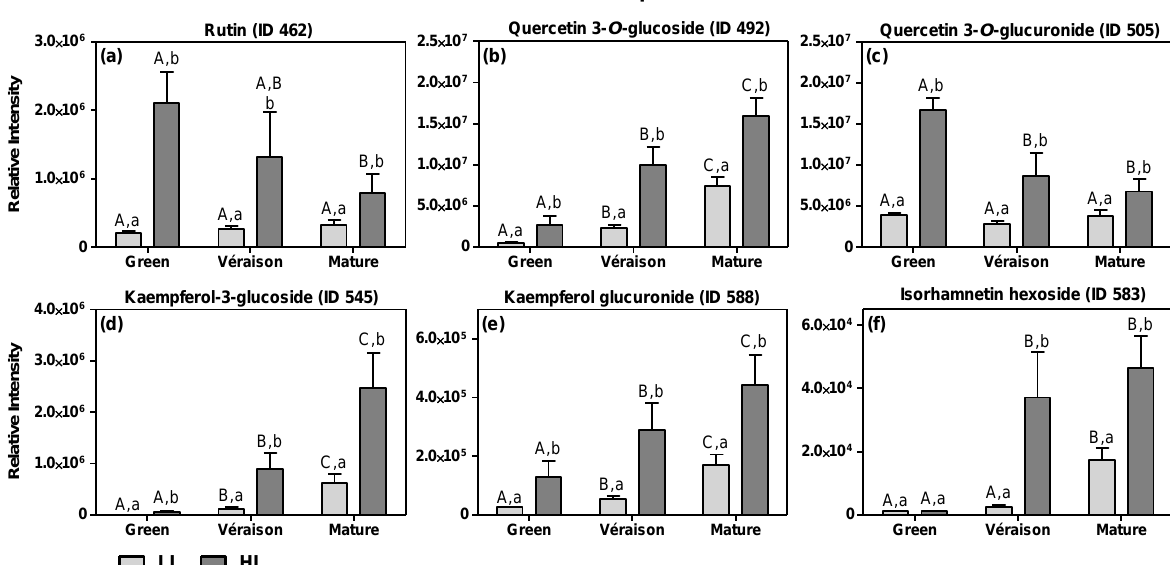
Figure 3. Relative intensities of the six main flavonol compounds as detected by LCMS (means and SD of n = 8–12) for exocarp tissue at two canopy microclimates (LL and HL; independent of mitigation treatment) and at three developmental stages (green, véraison and mature). The flavonols considered are: ( a ) rutin (quercetin-3- O -rutinoside) (ID 462), ( b ) quercetin 3- O -glucoside (ID 492), ( c ) quercetin 3- O -glucuronide (ID 505), ( d ) kaempferol-3-glucoside (ID 545), ( e ) kaempferol glucuronide (ID 588) and ( f ) isorhamnetin hexoside (ID 583) (Supplemental File 1, Tables S5–S7). Statistical analysis (two-way ANOVA, p ≤ 0.05) was applied after data Log 2 transformation. Statistical notation above the bars: the capital letters refer to differences between developmental stages for the same microclimate, while the lowercase letters refer to differences between the two light microclimates for each